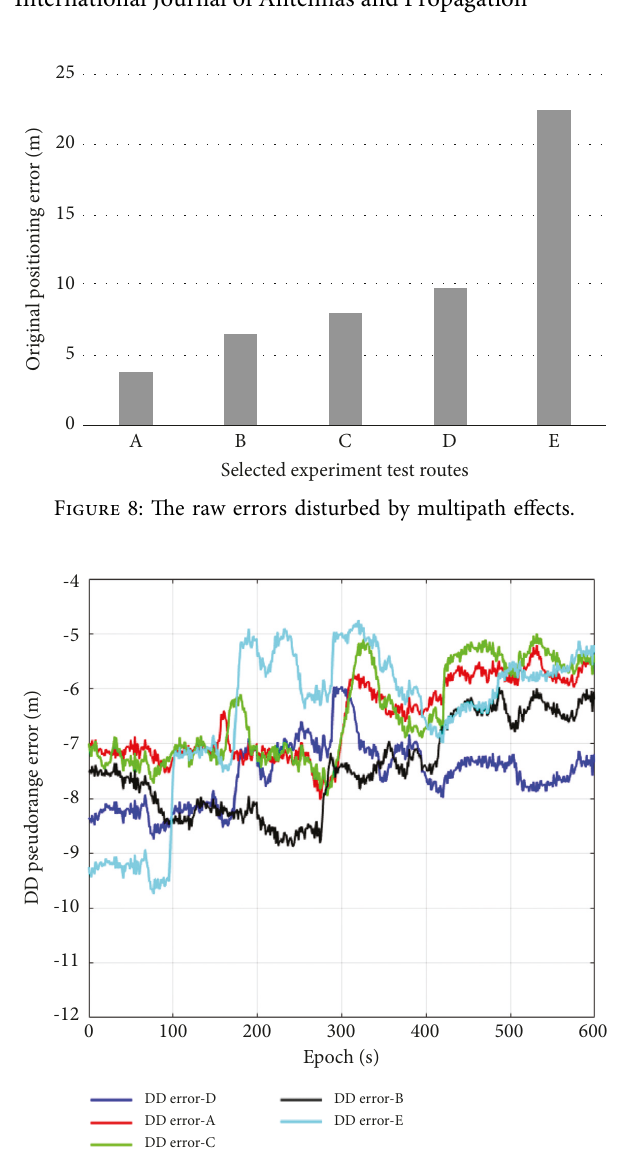
Figure 9: The trend in pseudorange error of MP under DD